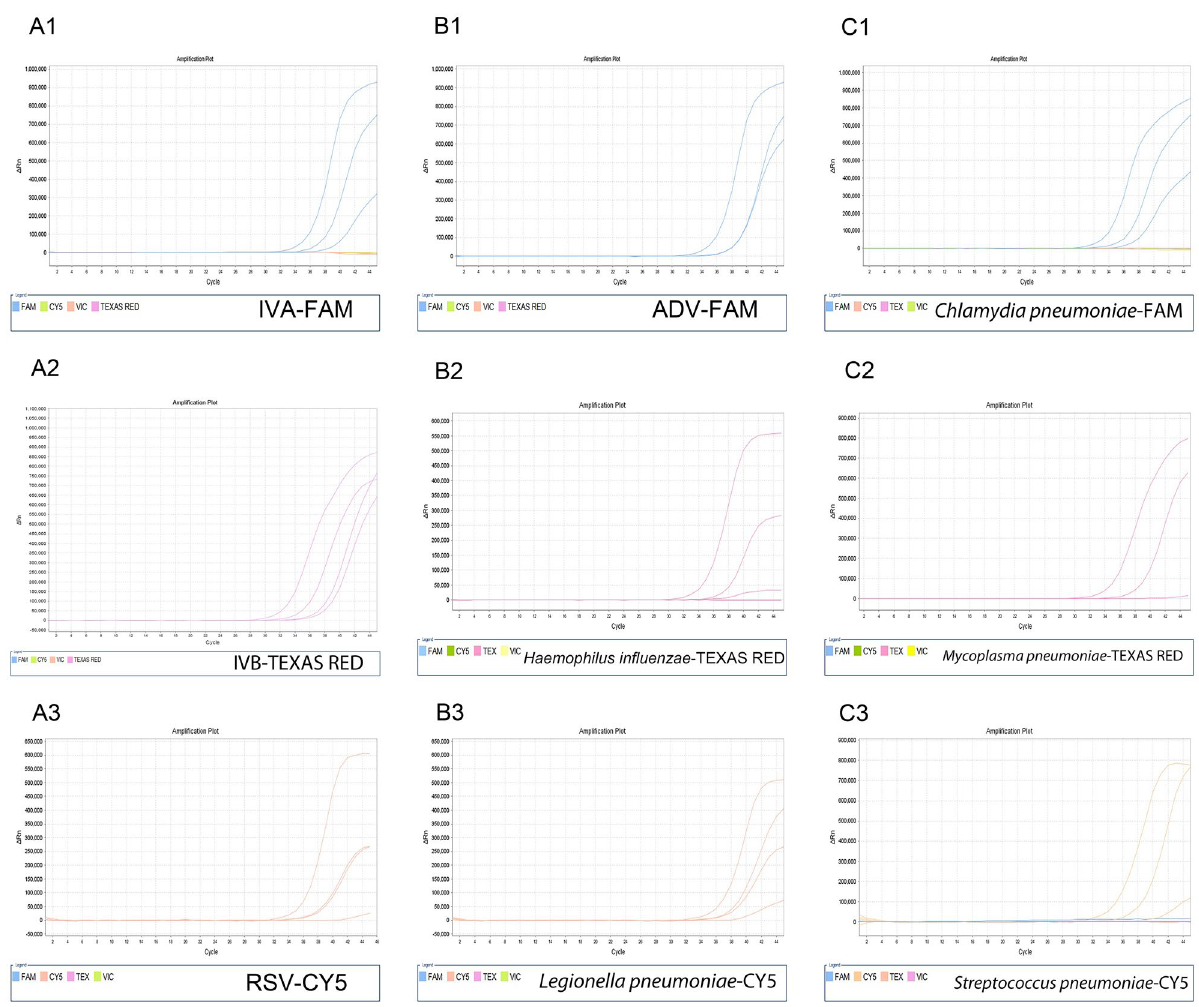
Figure 3. Analytical sensitivity of the multiplex real-time RT-PCR. Two-fold dilutions of the nucleic acids extracted from target pathogens (1000 copies/ml to 125 copies/ml). A1–A3, B1–B3 and C1–C3 are the amplification curves of the corresponding pathogens in tube A, B and C, respectively. Among them, all curves of 500 copies/ml were amplified, and IVA, IVB and Chlamydia pneumoniae were undoubtedly detected at 250